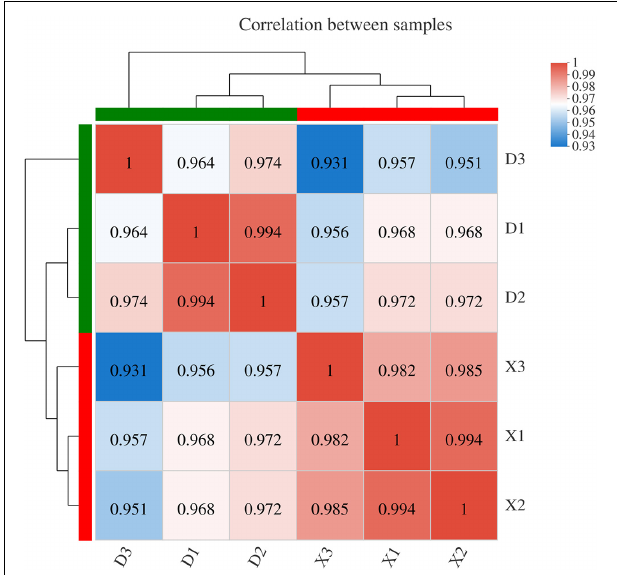
FIGURE 5 | Correlation analysis between different samples. Right and lower sides indicate sample names, X represents three replicates of the CG sample, and D represents three replicates of the EG sample. Left and upper sides are sample clustering, and squares of different colors represent the correlation between the two